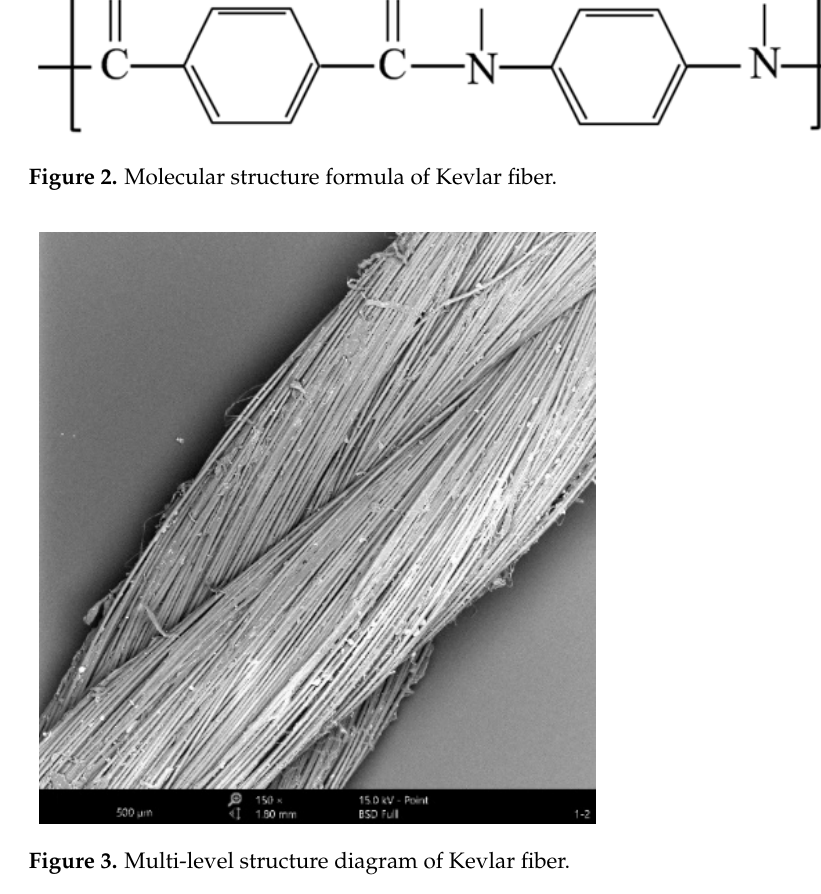
Figure 2. Molecular structure formula of Kevlar fiber.